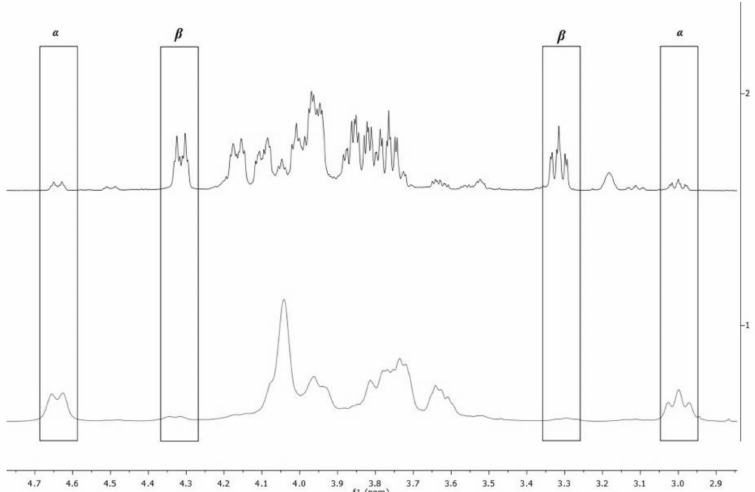
Figure 6. Analysis of the two 1 H-NMR spectra of [Ru 2 (pipeDTC) 5 ]Br obtained starting from our oxidized precursor ( above ) in comparison with the [Ru 2 (pipeDTC) 5 ]Cl obtained by reacting RuCl 3 (3 · H 2 O) with three equivalents of piperidine dithiocarbamate ( below ). Our new synthetic strategy shows a neat prevalence of β -[Ru 2 (pipeDTC) 5 ]Br.